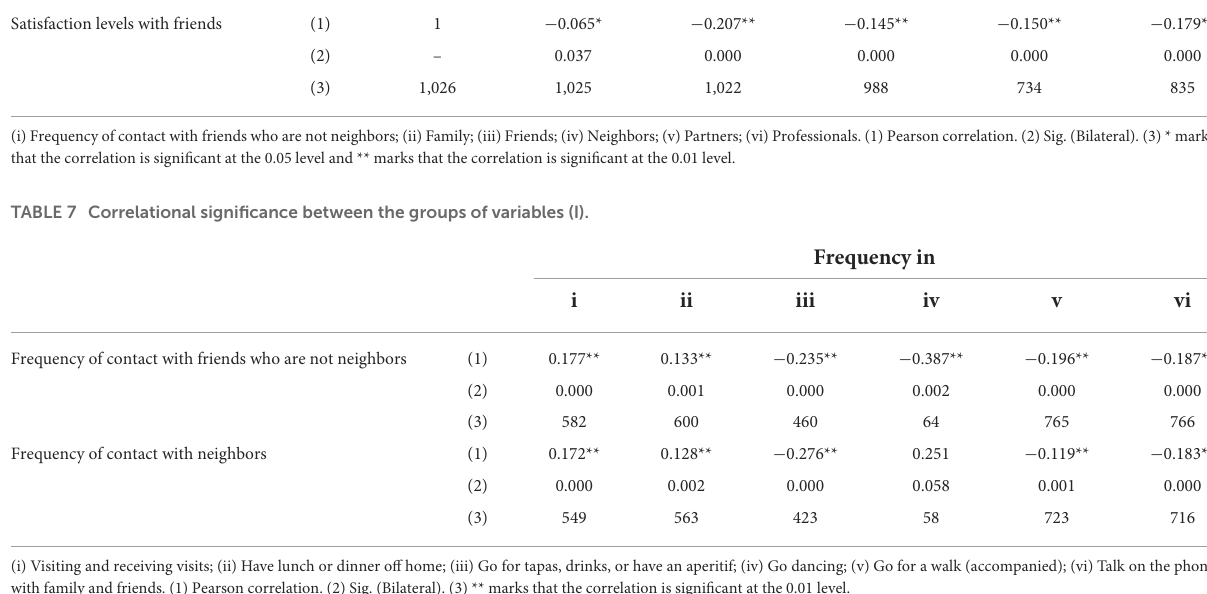
TABLE 6 Satisfaction levels from non-family interrelations.